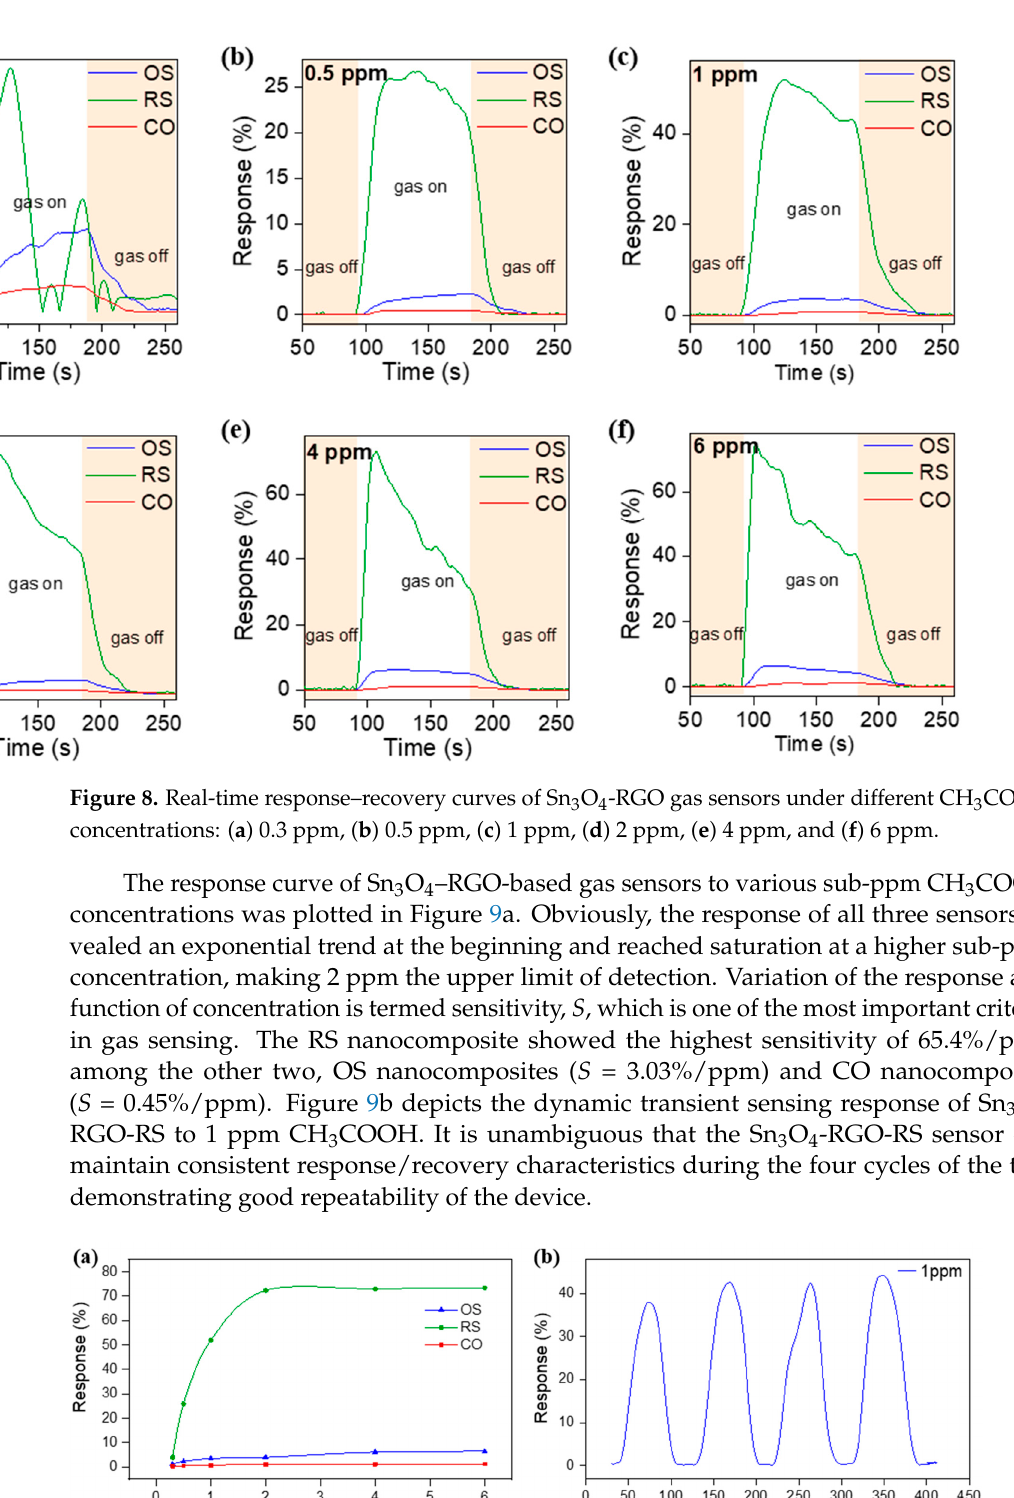
11 of 16 Figure 7. ( a ) I–V characteristic curve, ( b , c ) the response and recovery time of the Sn 3 O 4 -RGO-based sensor to various concentrations CH 3 COOH at room temperature. Figure 8a–f demonstrates the individual transient response and recovery curves of the three sensors exposed to various CH 3 COOH concentrations. Each exposure and re- covery cycle is carried out in a 90 s interval under gas exposure followed by a recovery interval of 90 s under dry air conditions. Each cycle is indicated by the white area in the graph marking the start and end. Clearly, the corresponding response values of the lowest concentration 0.3 ppm are about 1.4% ( t res = 66 s, t rec = 41 s) and 0.4% ( t res = 46 s, t rec = 32 s) detected by OS nanocomposite and CO nanocomposite, respectively. The fluctuating re-